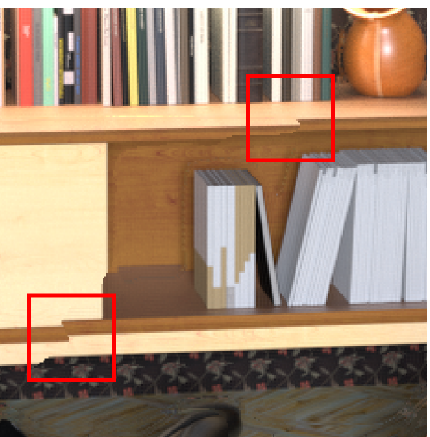
Figure 14. Error in light field synthesis using fewer images in the focal